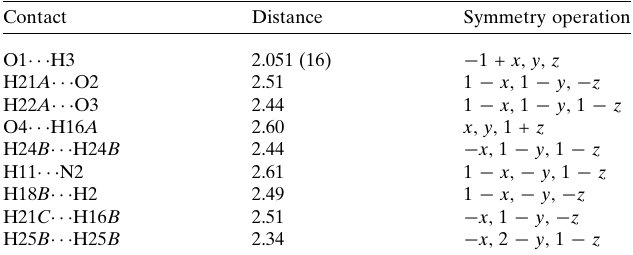
Table 2 Summary of short interatomic contacts (A˚ ) in the title compound. Contact Distance Symmetry